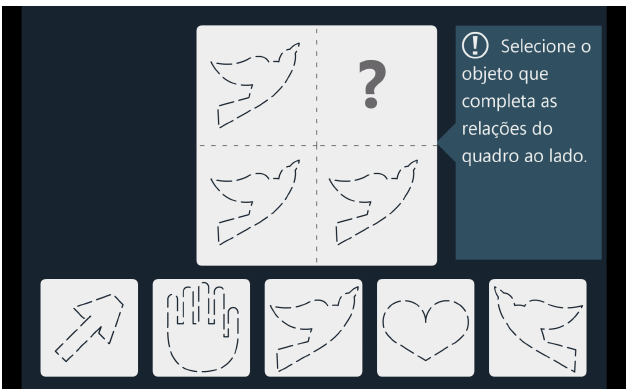
Fig. 3. Test based on Beta-III.